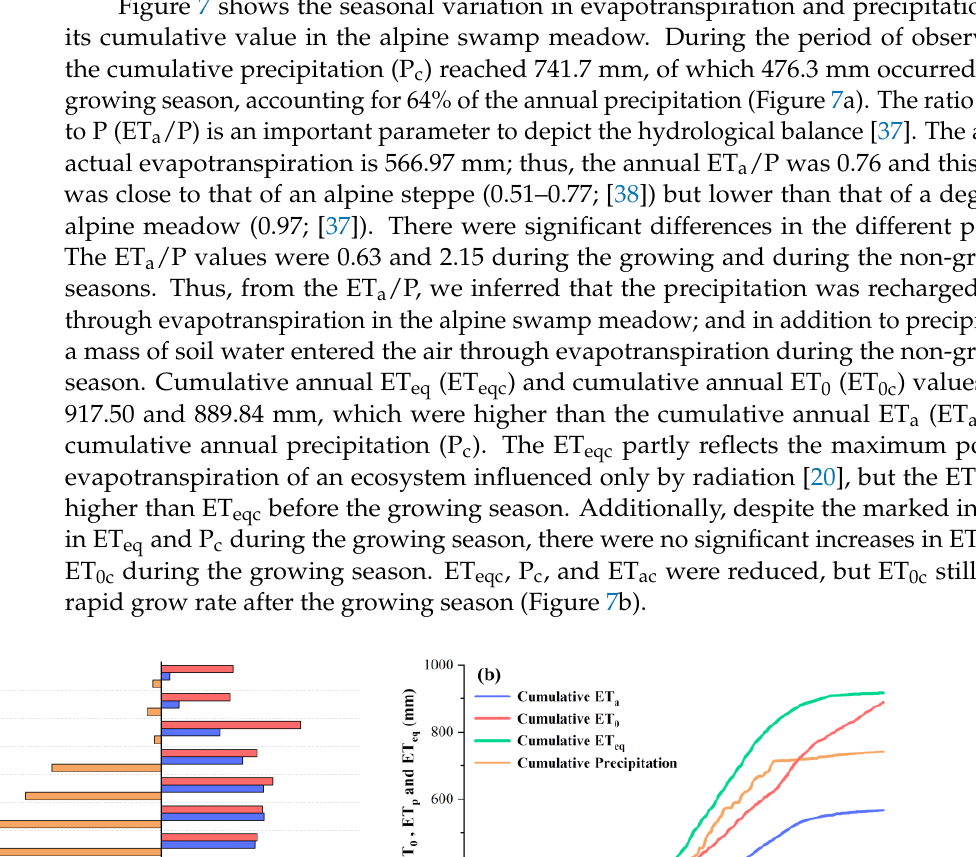
Table 2. Results of the stepwise regression.